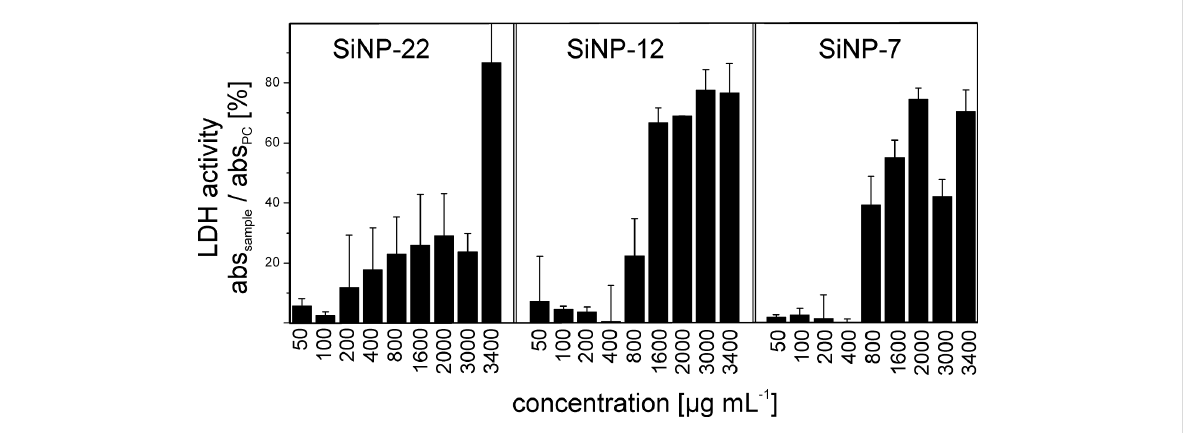
Figure 6: Level of LDH release of HeLa cells after incubation with silica NPs for 2 h. The extent of extracellular LDH is expressed as a normalized quotient to the positive control (PC).